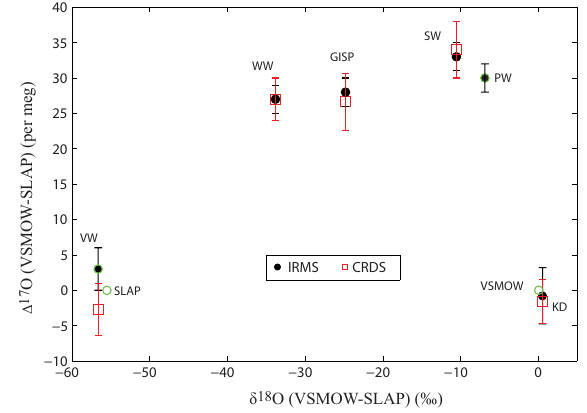
Figure 6. Comparison of 1 17 O data from two independent sets of calibrations of reference waters and standards measured by laser spectroscopy on the L2140- i (CRDS, open squares) with previously determined values from mass spectrometry (IRMS, filled circles). 1 17 O data are plotted vs. δ 18 O. Error bars on the CRDS values are the standard deviation of the mean (see Table 2). Values and er- ror bars (1 standard error) on the IRMS values are from Table 1, updated from Schoenemann et al. (2013). The calibration points VSMOW, SLAP, PW and VW are shown as open circles for ref-